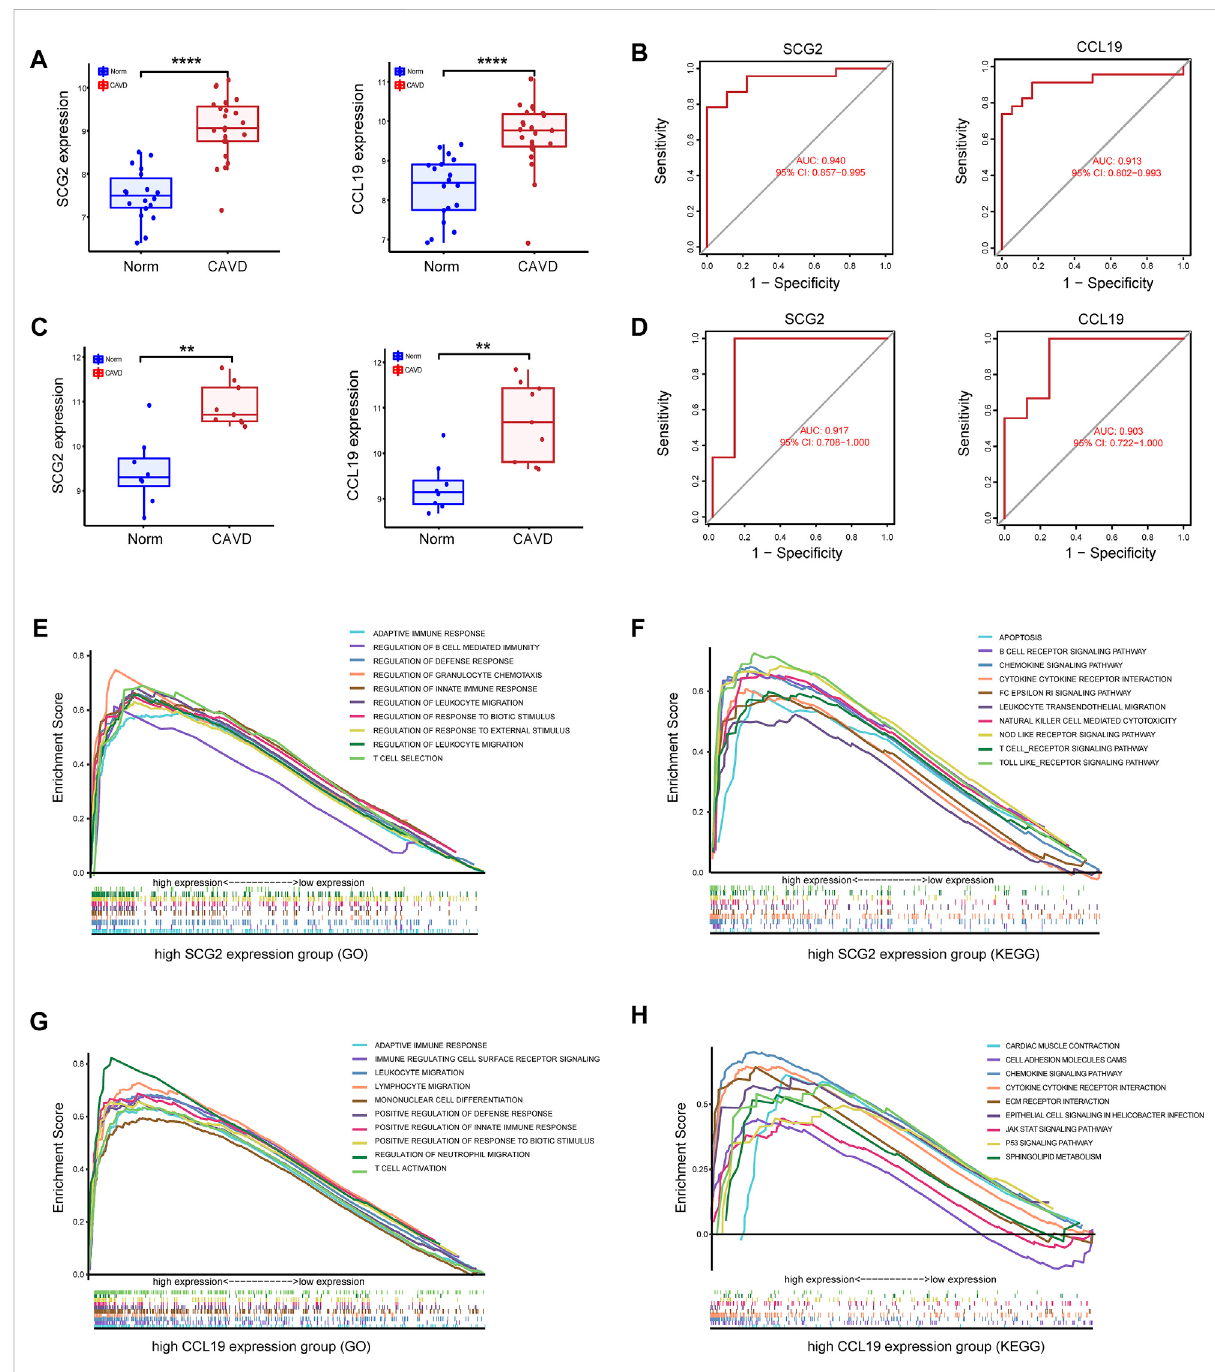
FIGURE 5 Validation of key genes SCG2 and CCL19. (A,B) Validation of the expression and receiver operating characteristic (ROC) curve of SCG2 and CCL19 in the merged metadata cohort. (C,D) Validation of the expression of SCG2 and CCL19 and ROC curve for evaluating the discriminatory accuracy of SCG2 and CCL19 in the validation dataset GSE83453. (E,F) GSEA analysis result show the top ten enrichment terms (GO and KEGG respectively) of regrouped high SCG2 expression group. (G,H) GSEA analysis result show the top ten enrichment terms (GO and KEGG respectively) of regrouped high CCL19 expression group. ** p < 0.01, **** p <